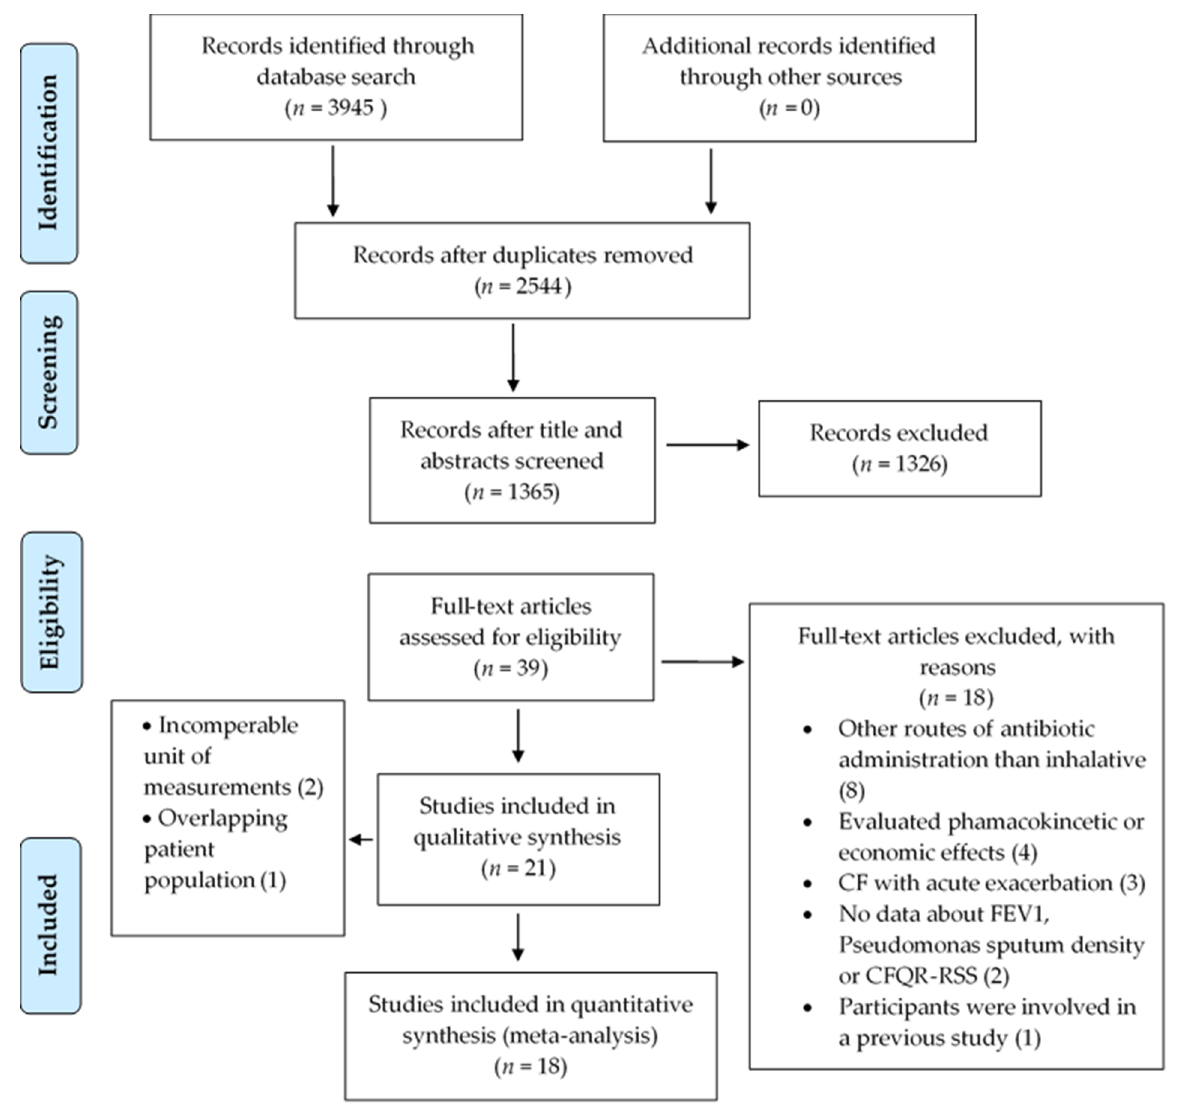
Figure 3. PRISMA flow chart.